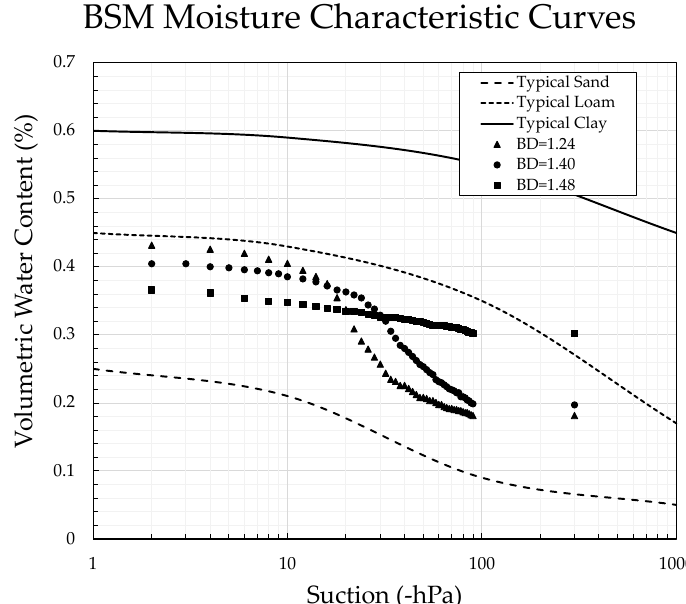
Figure 3. Moisture retention curves for the BSM expressed as the suction (–pressure) required to extract water from the bioretention soil matrix. Different levels of soil compaction are represented as bulk density “BD” in g cm − 3 in the figure legend. The BSM compacted to 1.48 g cm − 3 had a markedly higher field capacity than the 1.40 g cm − 3 BSM, which more closely followed the characteristic curve of the uncompacted BSM (1.24 g cm − 3